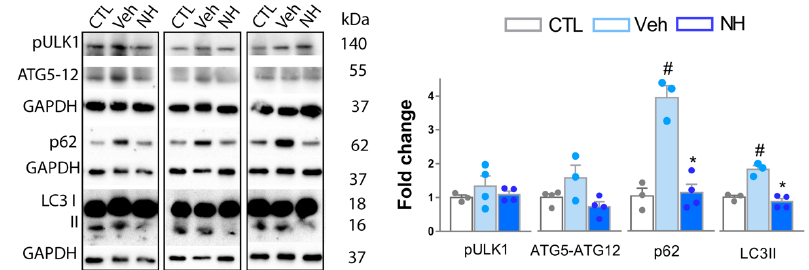
Figure 5. NeuroHeal treatment resolves autophagic blockage triggered after SNI. Western blot and corresponding bar graphs of the quantification of different proteins related to autophagy (pULK (Ser-555), ATG5, LC3-II, and p62) in the dorsal horn from L4-L5 spinal cords from Control (CTL), Vehicle (Veh), or NeuroHeal (NH) treated animals. ( n = 3–4 biological replicates, ANOVA, post hoc Bonferroni, * p < 0.05 vs. Veh, # p < 0.05 vs.